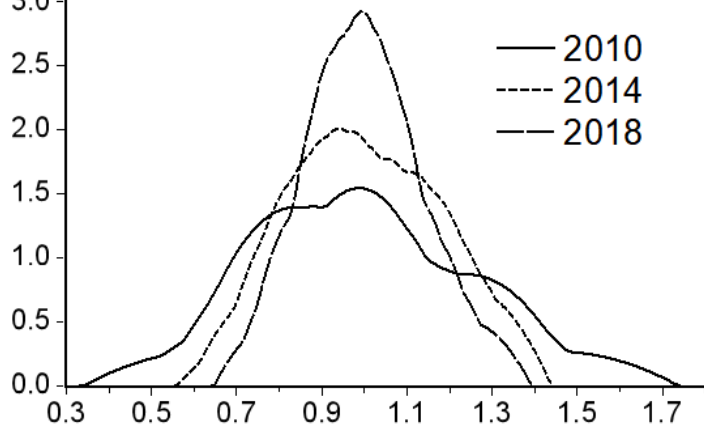
Figure 1. Kernel density estimation of the number of health personnel per 10,000 people in western economic belt provinces.